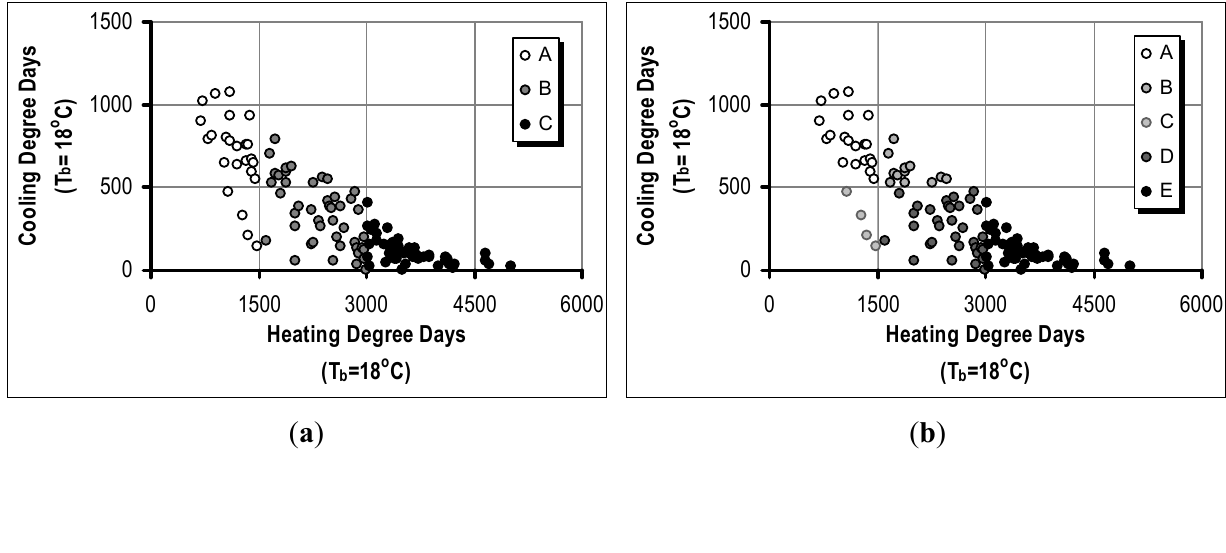
Figure 3. The areas representing high, medium and low heating and cooling needs according to the first approach ( a ) and the second approach ( b ), also presented in Table